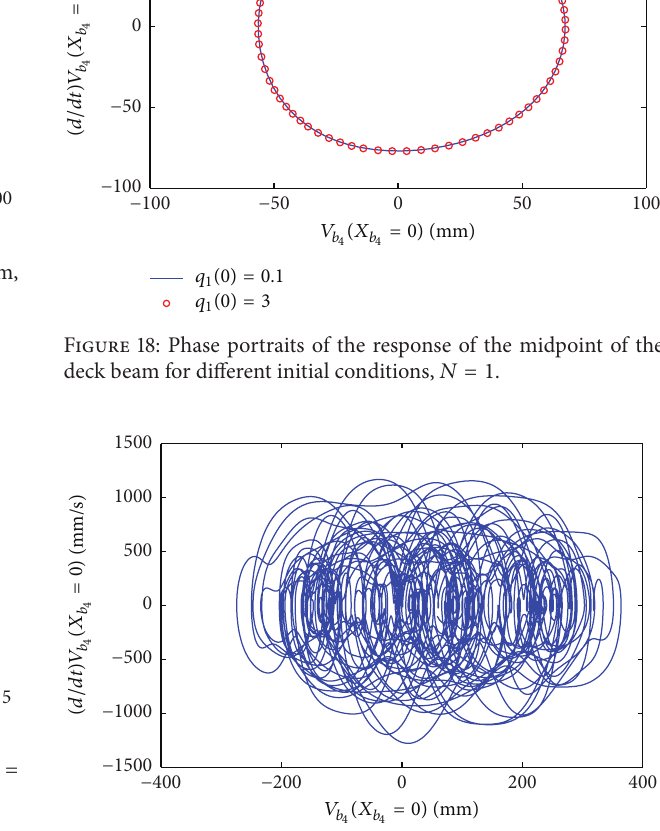
Figure 19: Chaotic response of the midpoint of the deck beam, (0) = 0.1𝛿 𝑞 𝑟 2𝑟